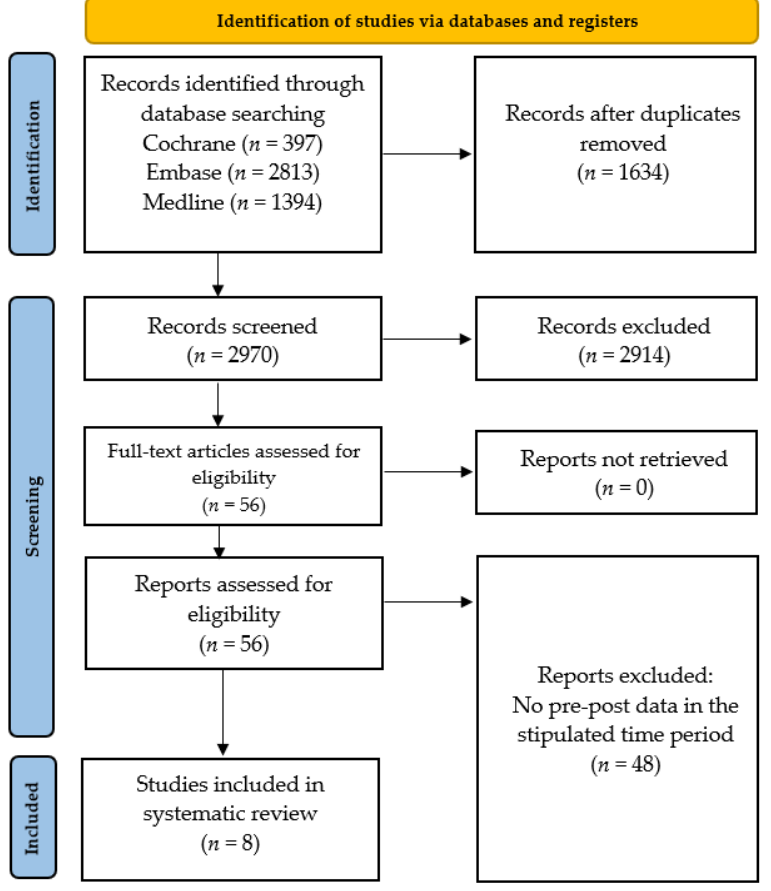
Figure 1. PRISMA flowchart showing the study abstraction process.